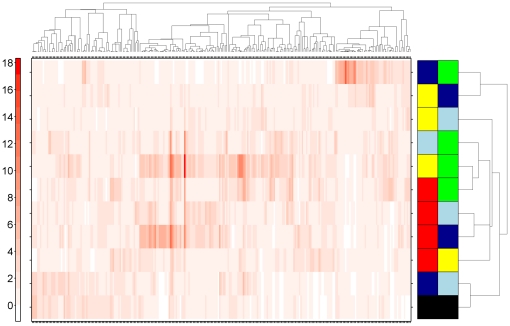
Gene Ontology Analysis of Differentially-Expressed Genes.To identify functional trends and similarities amongst pairs of strains, we again employed Gene Ontology enrichment analysis. Those genes differentially expressed (padjusted<0.05) in each strain were used, and only those GO terms significantly enriched at a cumulative probability of pcumulative<10−10 were selected. The p-values for these selected GO terms were subjected to divisive hierarchical clustering, with the contrasts as rows, the GO terms as columns, and the colour of individual cells indicating the −log10 of the p-value for enrichment. The two colour bars on the right side of the figure indicate the two strains compared in this contrast. Yellow, Long-Evans; Red, Han/Wistar; Dark Blue, Line-A; Light Blue, Line-C; Green, Sprague-Dawley; Black, AHR.